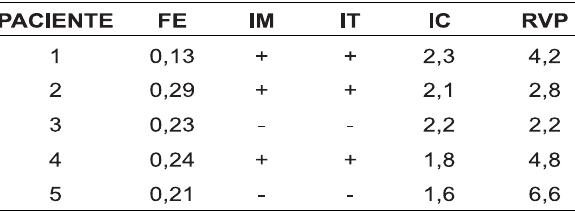
Fig. 2 - Monitorização do NO administrado e do NO (PrinterNOx – White Martins).